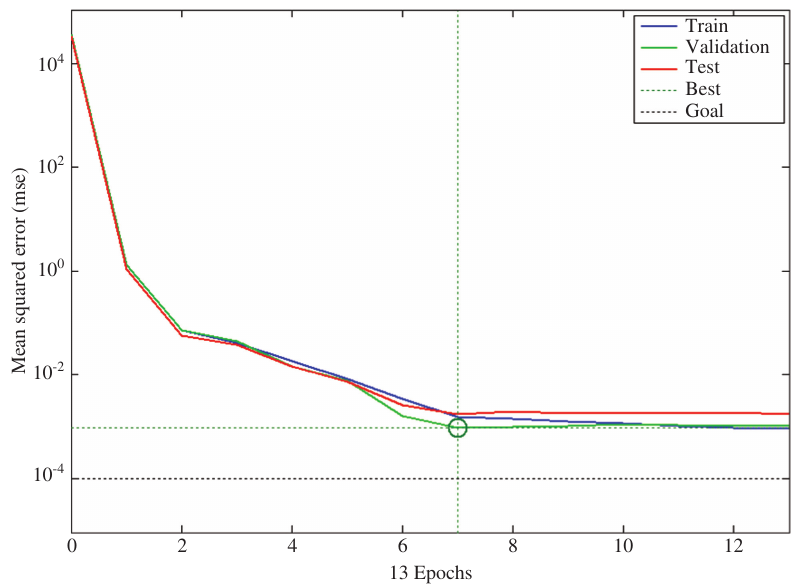
Figure 5 Performance of NN 6-6-1.